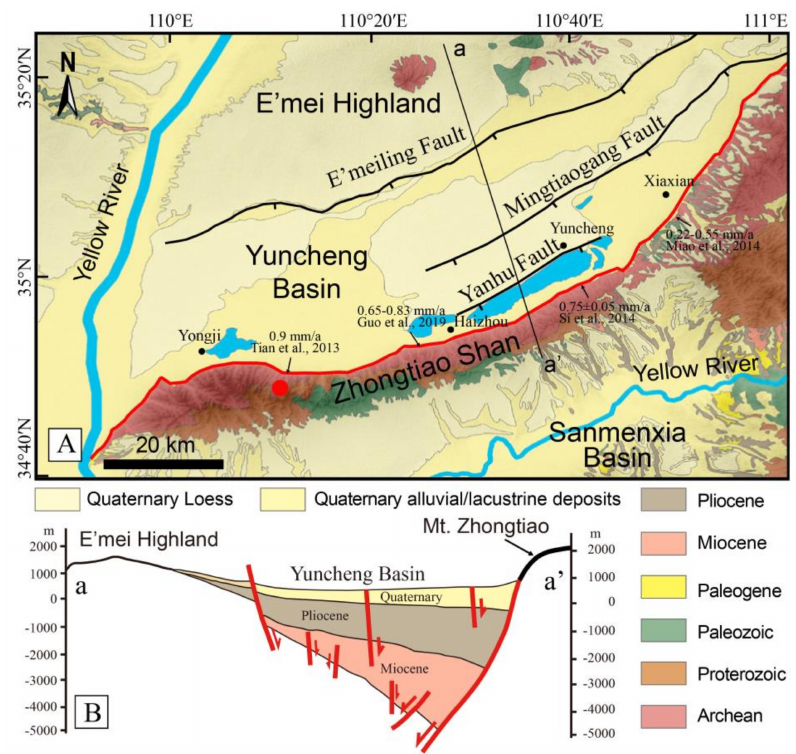
Figure 2. ( A ) Simplified geological map of the Yuncheng Basin and the Zhongtiao Shan with the main geomorphic units and active faults. The red line shows the location of the NZTF. The red dot shows the location of the Xuehua Shan. The base map is revised from [27]). ( B ) Simplified cross-section of the Yuncheng Basin and the Zhongtiao Shan along the a-a’ profile shown in Figure 2A. The faults and the strata are adopted from